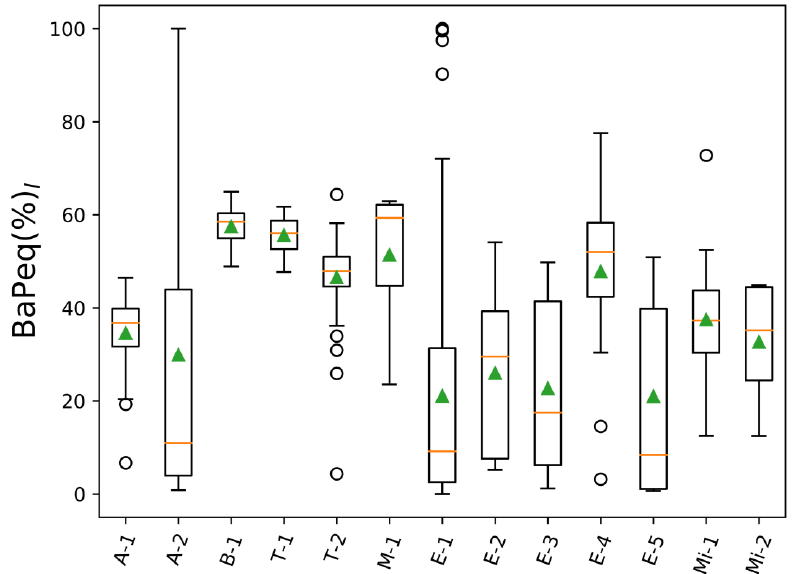
Figure 1. BaPeq ratios of 16 U.S Environmental Protection Agency (EPA) particle-phase PAHs to 88 particle-phase PAHs (BaP eq (%) I = PM ∑ 16EPA BaP eq /PM ∑ 88 BaP eq ); orange lines—mean values of BaP eq (%) I ; green triangles—median values of BaP eq (%) I .